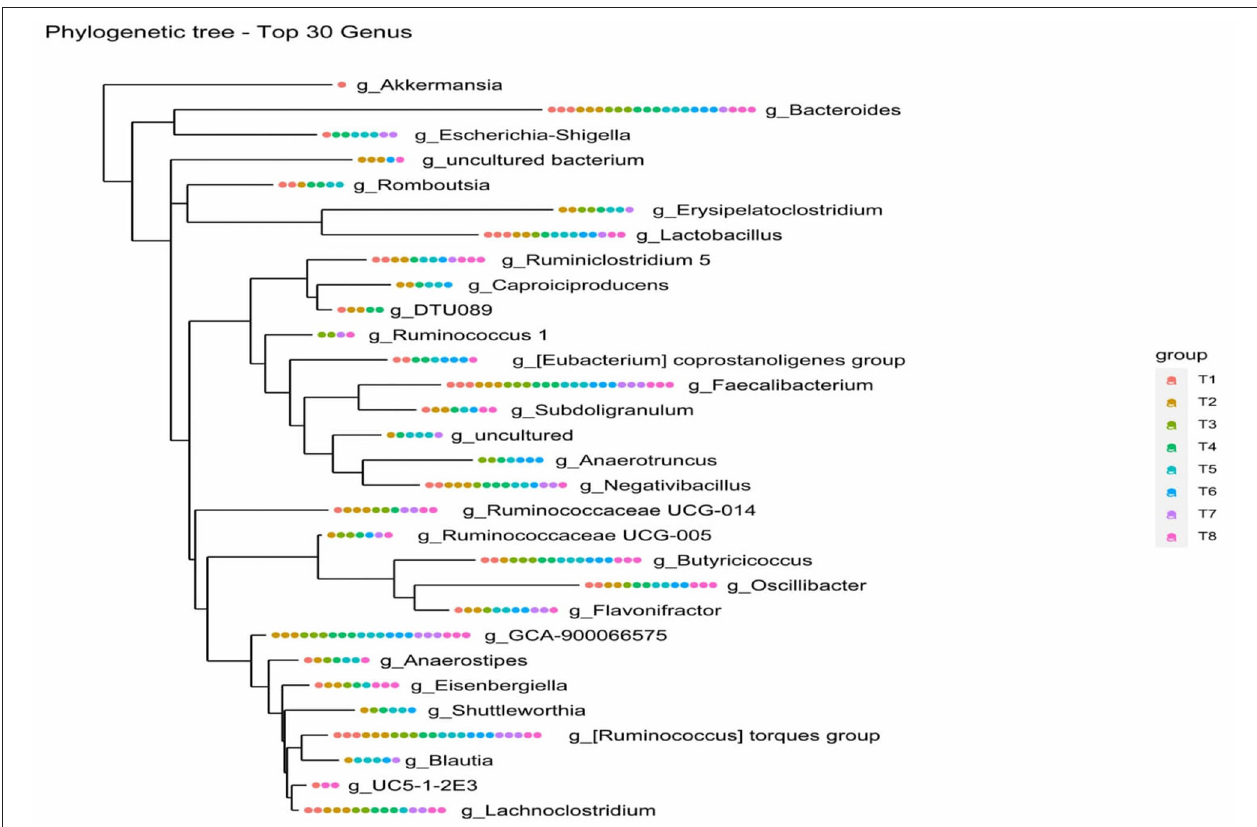
FIGURE 7 | Phylogenetic tree of top 30 genus of colon mucosa microbiota. T1 = Negative control (Basal diet), T2 = Positive control [Basalt diet + 0.01% (w/w) Oxytetracycline], T3 = Basal diet + 0.2% (v/w) postbiotic TL1, T4 = Basal diet + 0.2% (v/w) Postbiotic RS5, T5 = Basal diet + 0.2%(v/w) paraprobiotic RG11, T6 = Basal diet + 0.2% (v/w) postbiotic RI11, T7 = Basal diet + 0.2% (v/w) paraprobiotic RG14, T8 = Basal diet + 0.2% (v/w) paraprobiotic RI11. The genus Bacteroides was found in all the treatments, and the overall highest closely related